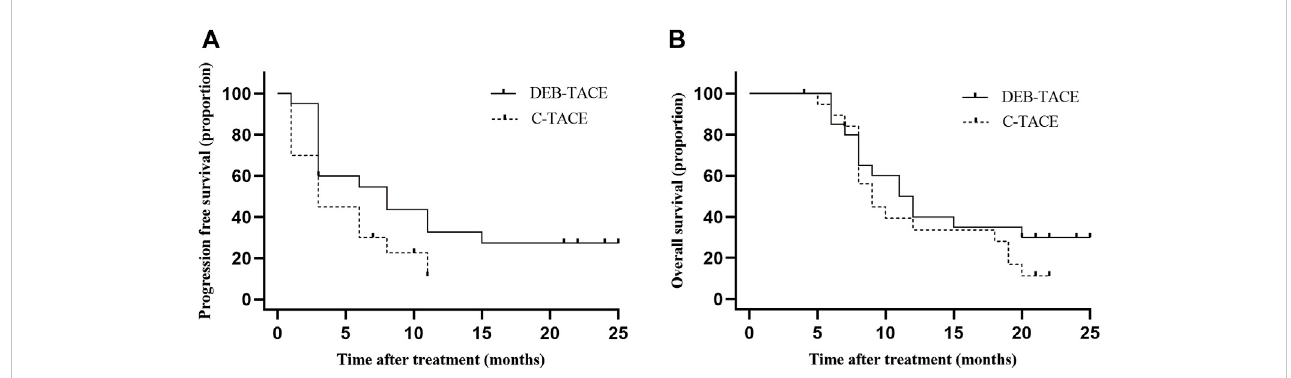
FIGURE 4 Kaplan-Meier curves shows all participants ’ PFS and OS. (A) median PFS was 8.0 months (95% CI: 1.2, 14.8) inthe DEB-TACE group and 3.0 months (95% CI: 1.6, 4.4) in the C-TACE group (hazard ratio, .5; 95% CI: .24, .94 p = .042); (B) median OS was 11.5 months (95% CI: 7.7, 14.3) in the DEB-TACE group and